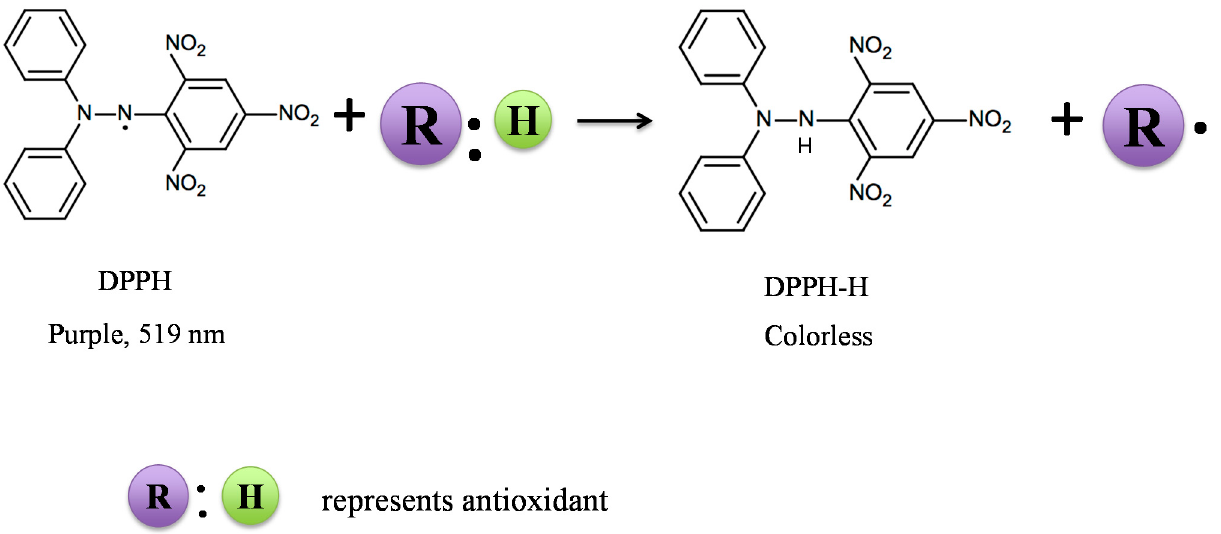
Figure 1. Reaction mechanism of 2,2-diphenyl-1-picrylhydrazyl (DPPH) with antioxidant. R : H = antioxidant radical scavenger; R = antioxidant